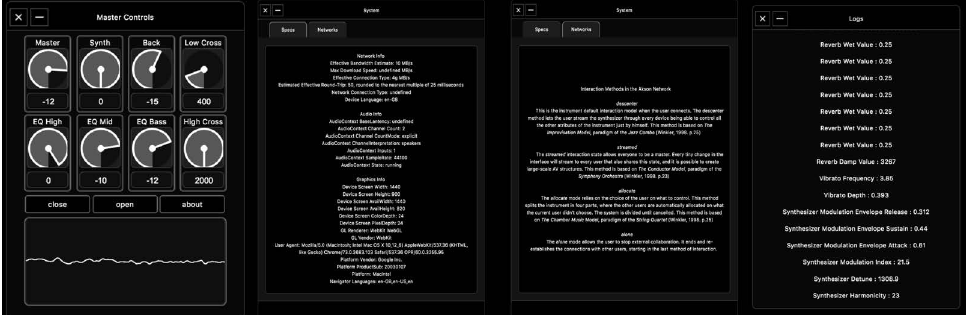
Figure 4: GUI Elements of Akson: 1) Master Dialog; 2) System Dialog; 3) Logs Dialog – from left to right.